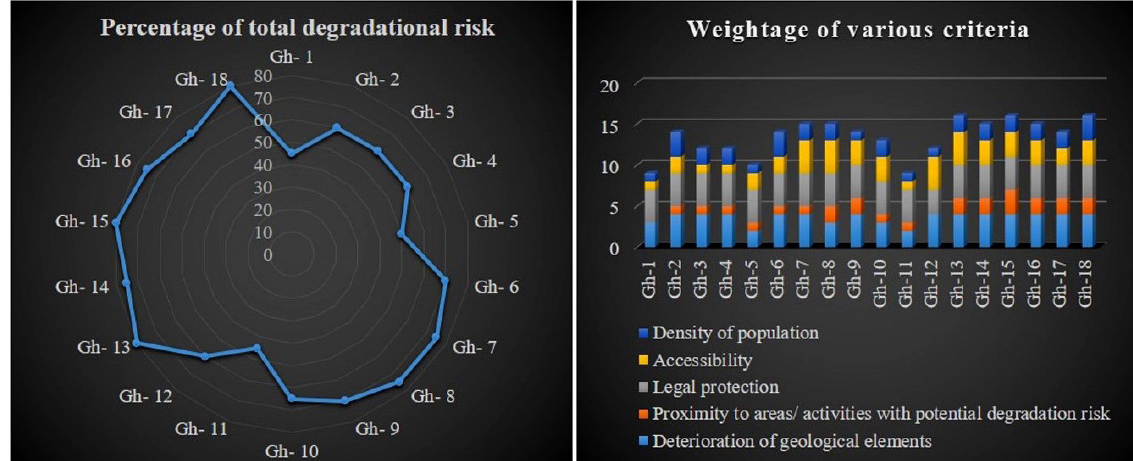
Figure 15. Assessment of the 18 geosites of Kachchh Province, Gh-1 to Gh-18, for degradation risk. Percentage of degradation risk (left) and weighting of various criteria of degradation risk